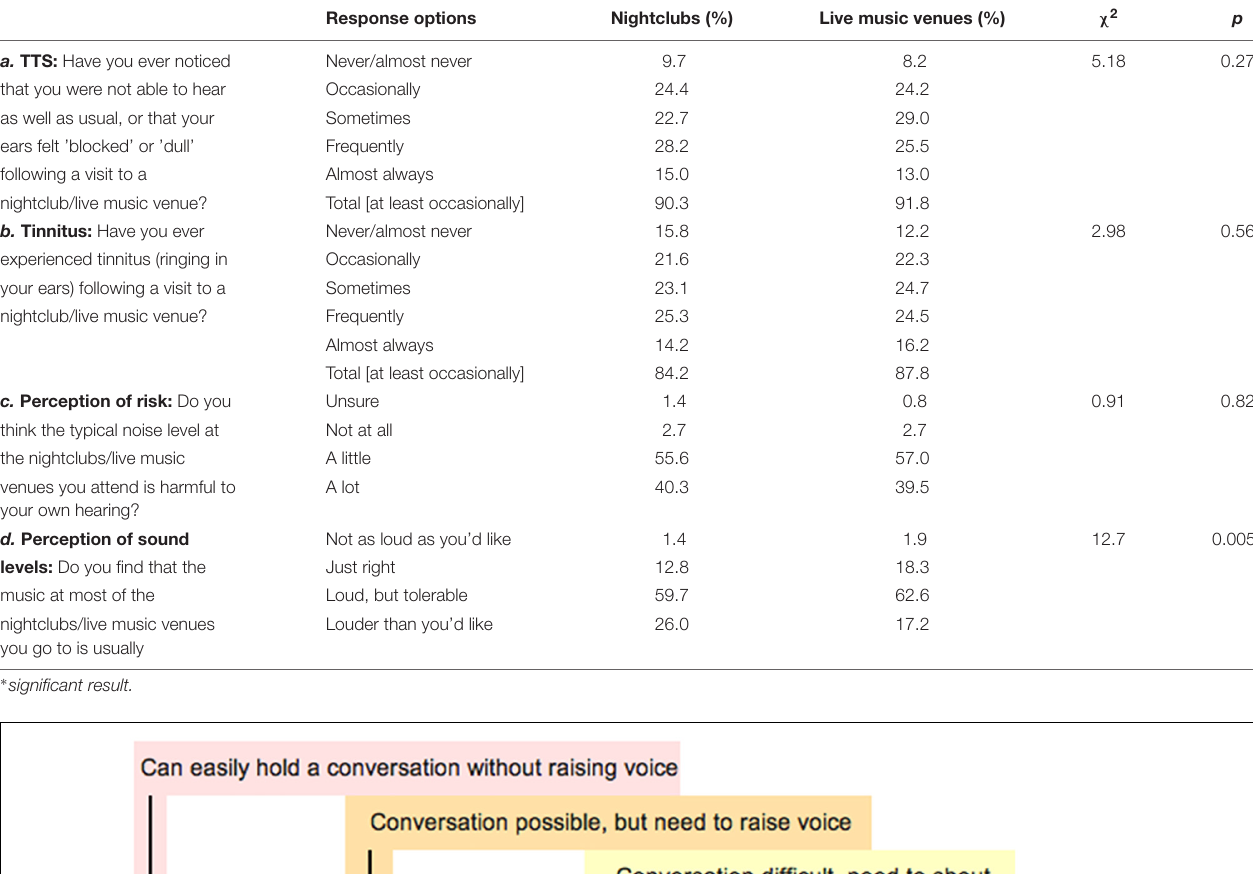
TABLE 1 | Percentages of participant responses to items a–d and results of chi-square tests of